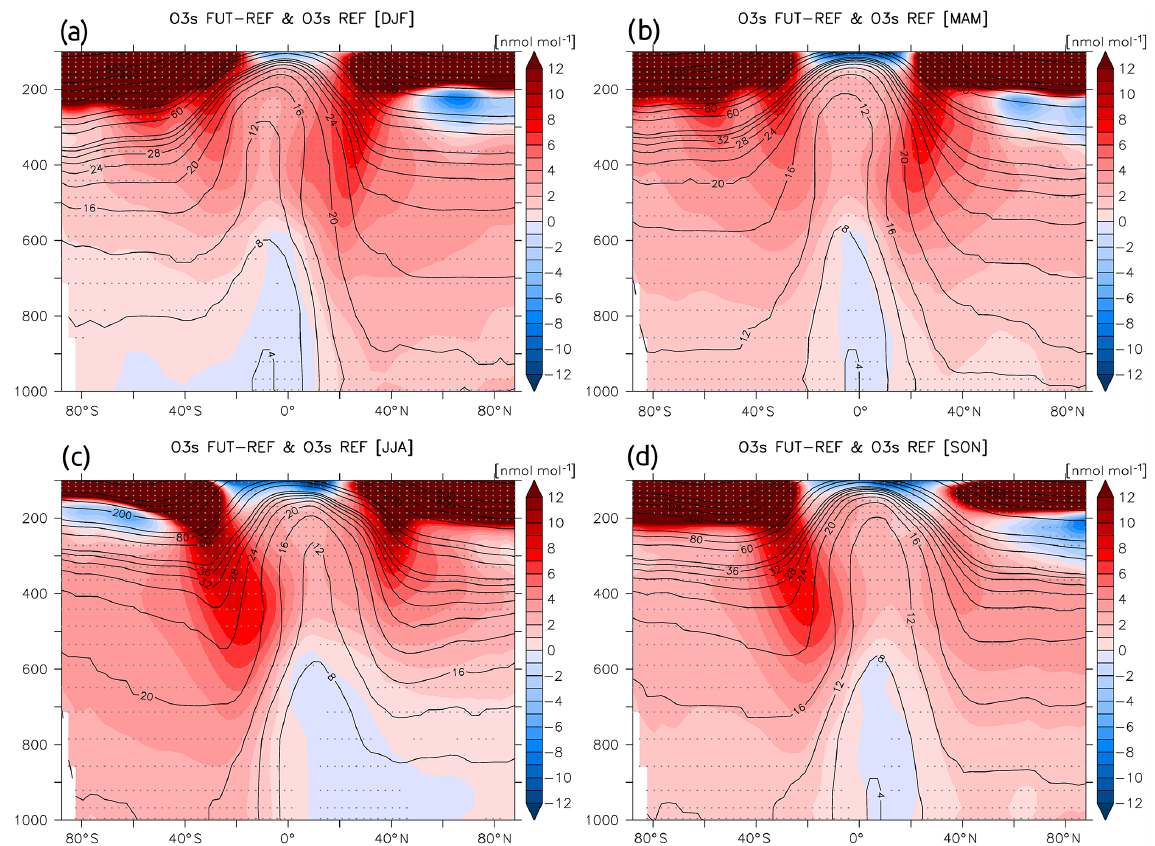
Figure 6. Differences of zonal-mean stratospheric ozone tracer (O 3 s) concentrations between the FUT and REF periods (shaded; nmolmol − 1 ) for DJF (a) , MAM (b) , JJA (c) , and SON (d) . The black contours denote the zonal-mean stratospheric ozone tracer con- centrations (nmolmol − 1 ) during the REF period. Grey dots denote statistically significant changes at the 99% confidence